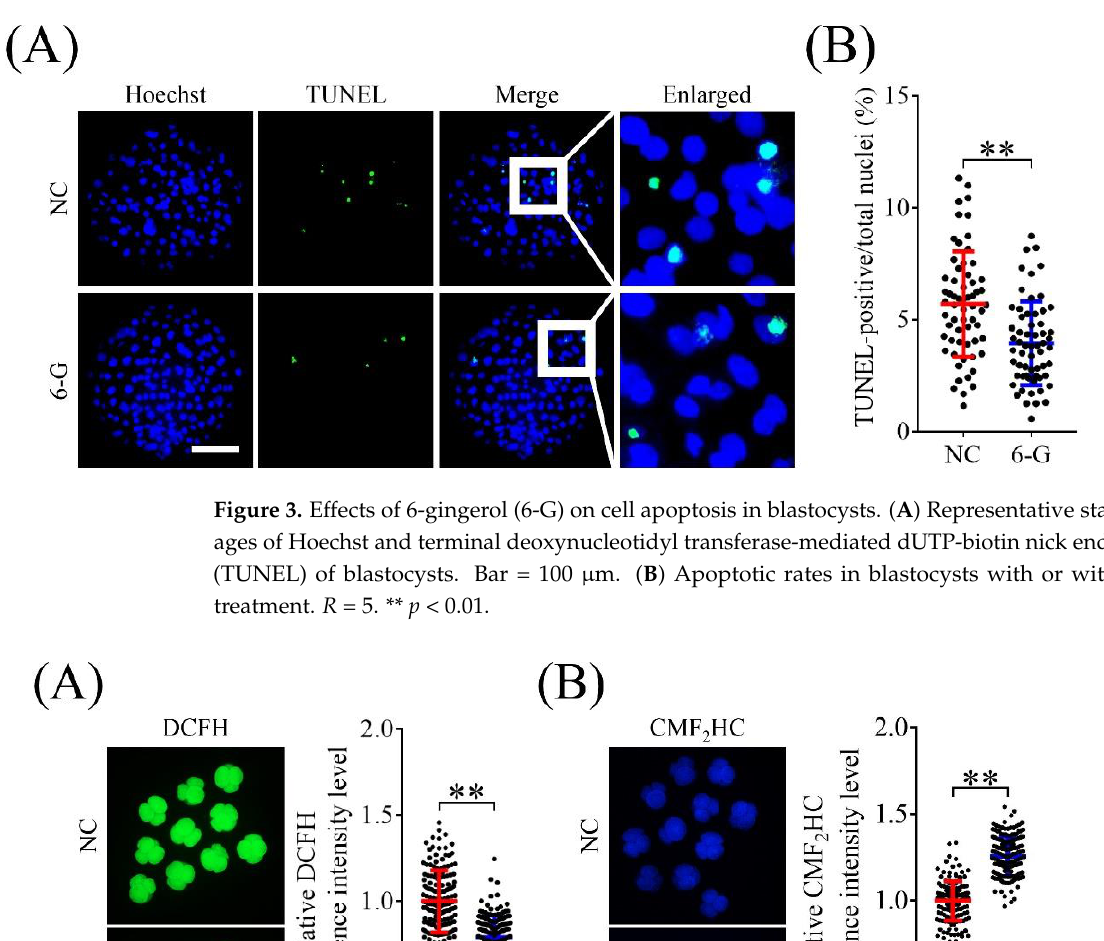
Figure 3. Effects of 6-gingerol (6-G) on cell apoptosis in blastocysts. ( A ) Representative staining im- ages of Hoechst and terminal deoxynucleotidyl transferase-mediated dUTP-biotin nick end-labeling (TUNEL) of blastocysts. Bar = 100 μm. ( B ) Apoptotic rates in blastocysts with or without 6-G treat- ment. R = 5. ** p < 0.01.